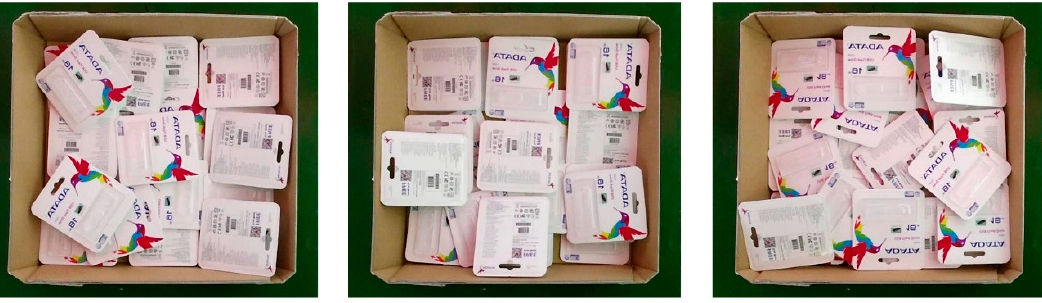
Figure 3. Three examples of actual scenarios.